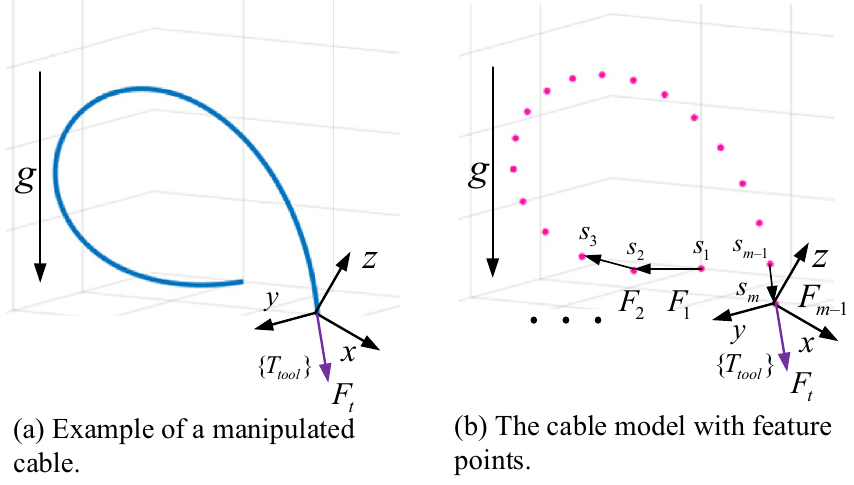
Figure 3. The feature model representation of the manipulated cable coupling effect to the